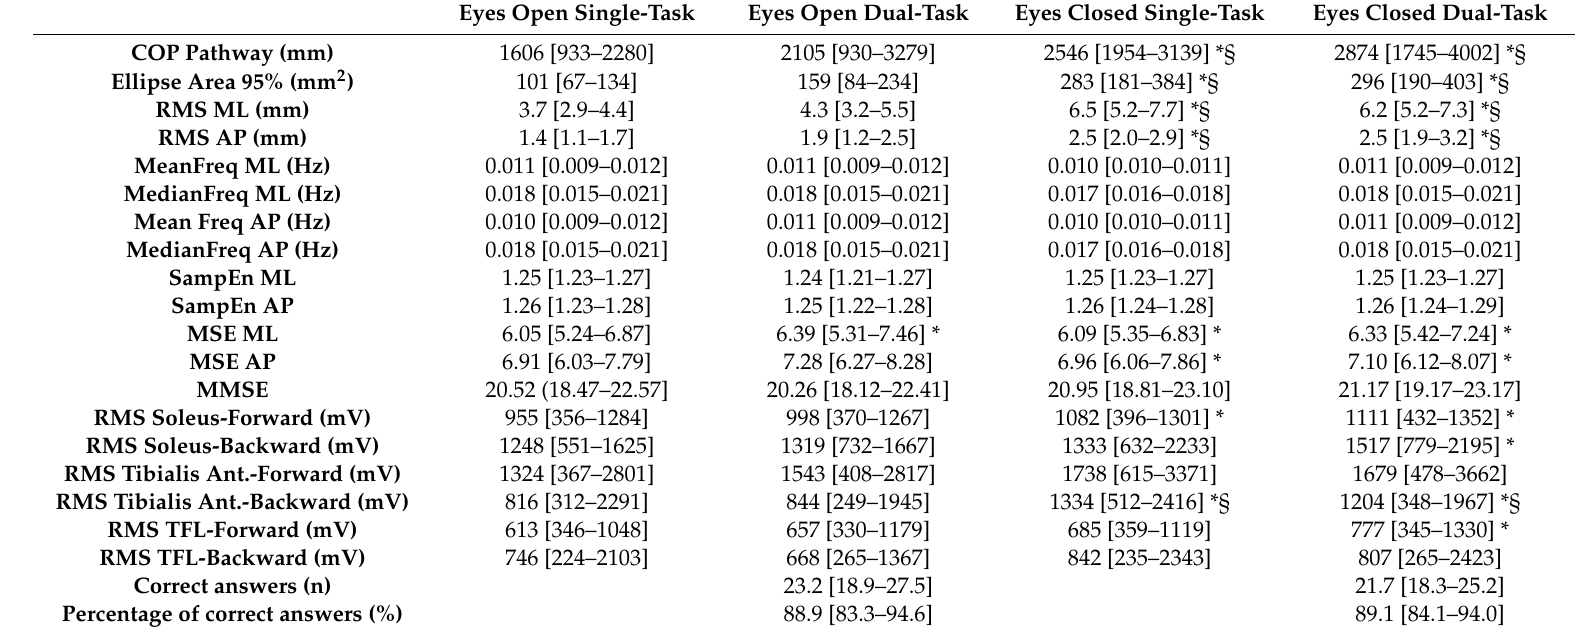
Table 2. Summary statistics (Mean [CI 95%]) for COP parameters, electromyographic RMS and cognitive performance in